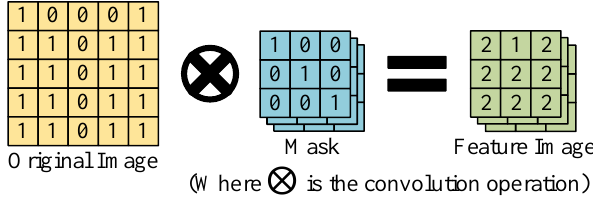
Figure 8. Schematic diagram of convolution layer operation.